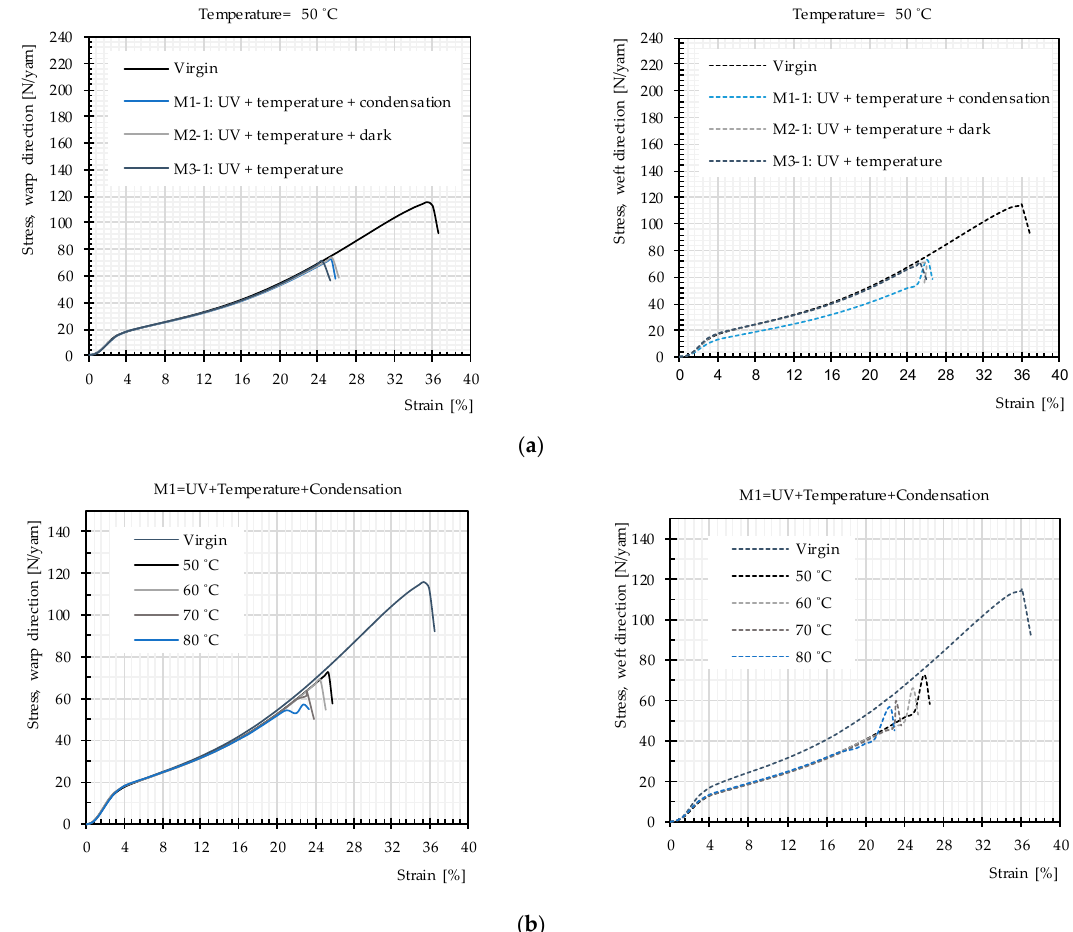
Figure 9. Mean stress–strain curves, uncoated PET Type III: ( a ) artificial weathering methods (M1-1–M3-1); and ( b ) artificial weathering Method M1.